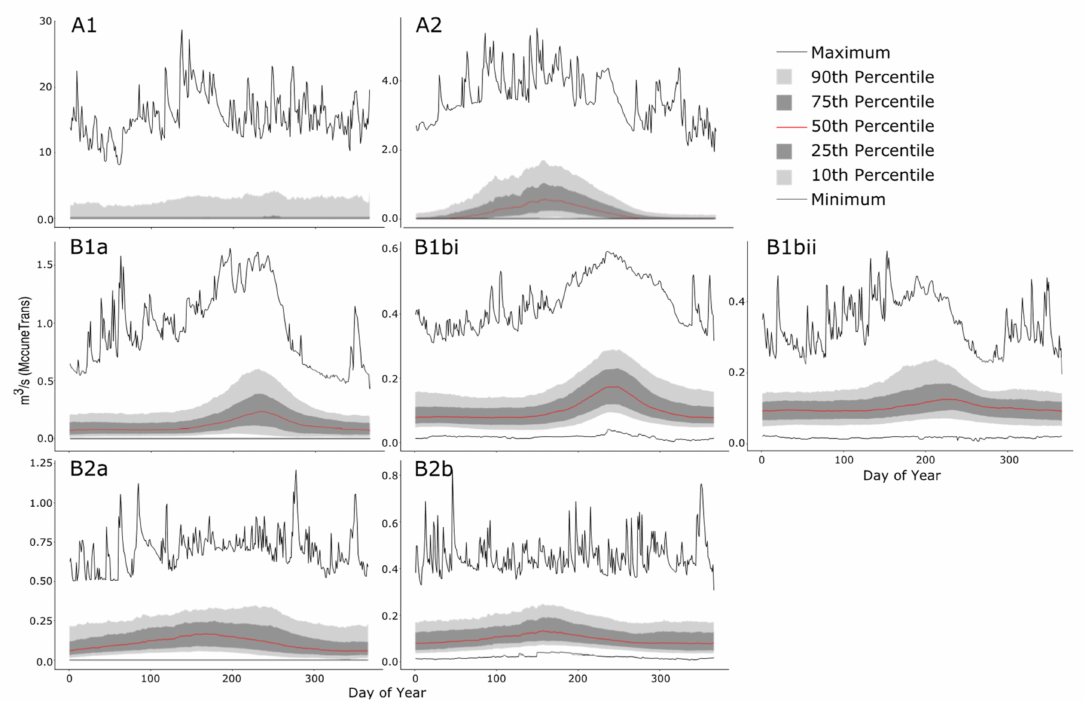
Figure 5. Dimensionless reference hydrographs (archetypes) for the seven most resolved classes (A1 to B2b). Day of year is based on water year, i.e., October 1 = day of year 1. The red line and shading trace the mean percentiles of mean daily flow values for each individual day of year calculated for each class across the full period of record. The black lines represent the maximum and minimum mean daily flows for each class on each day of record. The number of reaches in each class were A1 (39), A2 (53), B1a (36), B1bi (60), B1bii (30), B2a (44), and B2b